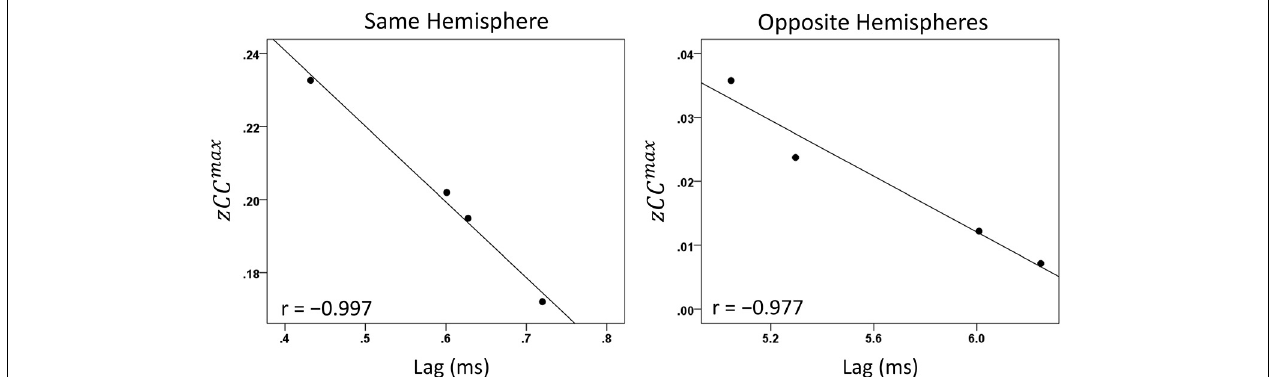
FIGURE 16 | Mean CC max per task period is plotted against its mean lag for same- and opposite-hemisphere recordings (see text for